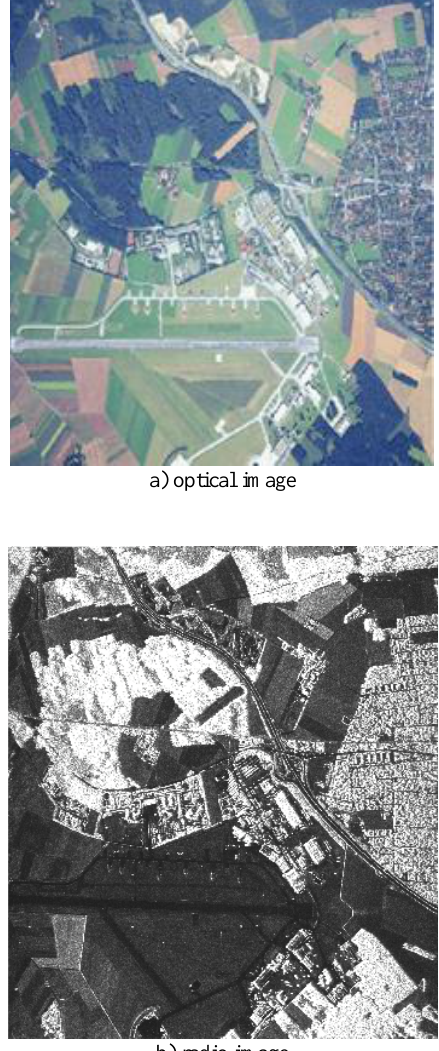
Figure 1 – Optical and radar image of one area of the